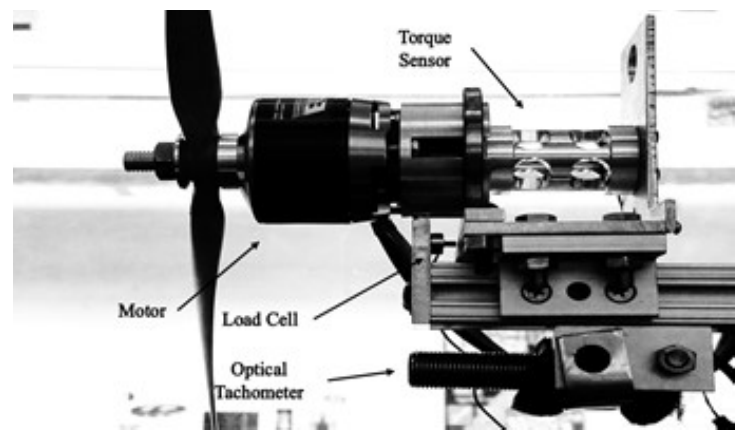
Figure 1. Previous OSU dynamometer for propeller flow